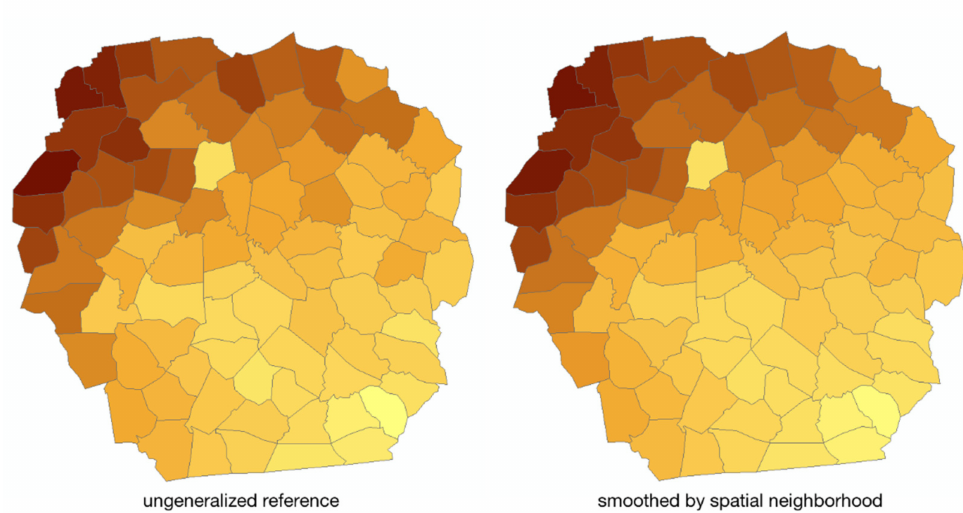
Figure 1. Slightly reduced local contrast in the spatially generalized version ( right ) of a frame from stimulus 1. The color of a local outlier polygon (bright polygon in the upper center) is not altered by generalization ( left